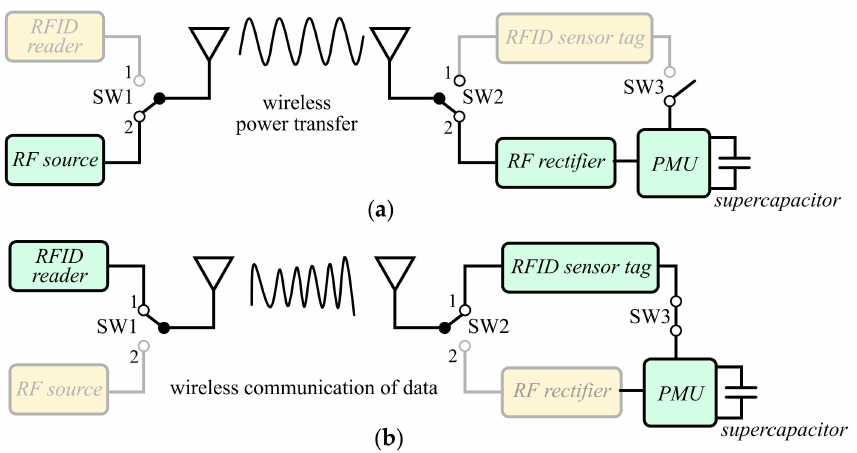
Figure 1. Block diagram of the proposed autonomous wireless sensor node during ( a ) wireless power transfer and ( b ) wireless data communication. SW1 controls the transmitting mode and SW2 and SW3 control the power supply of the radiofrequency identification (RFID) sensor tag. PMU: power management